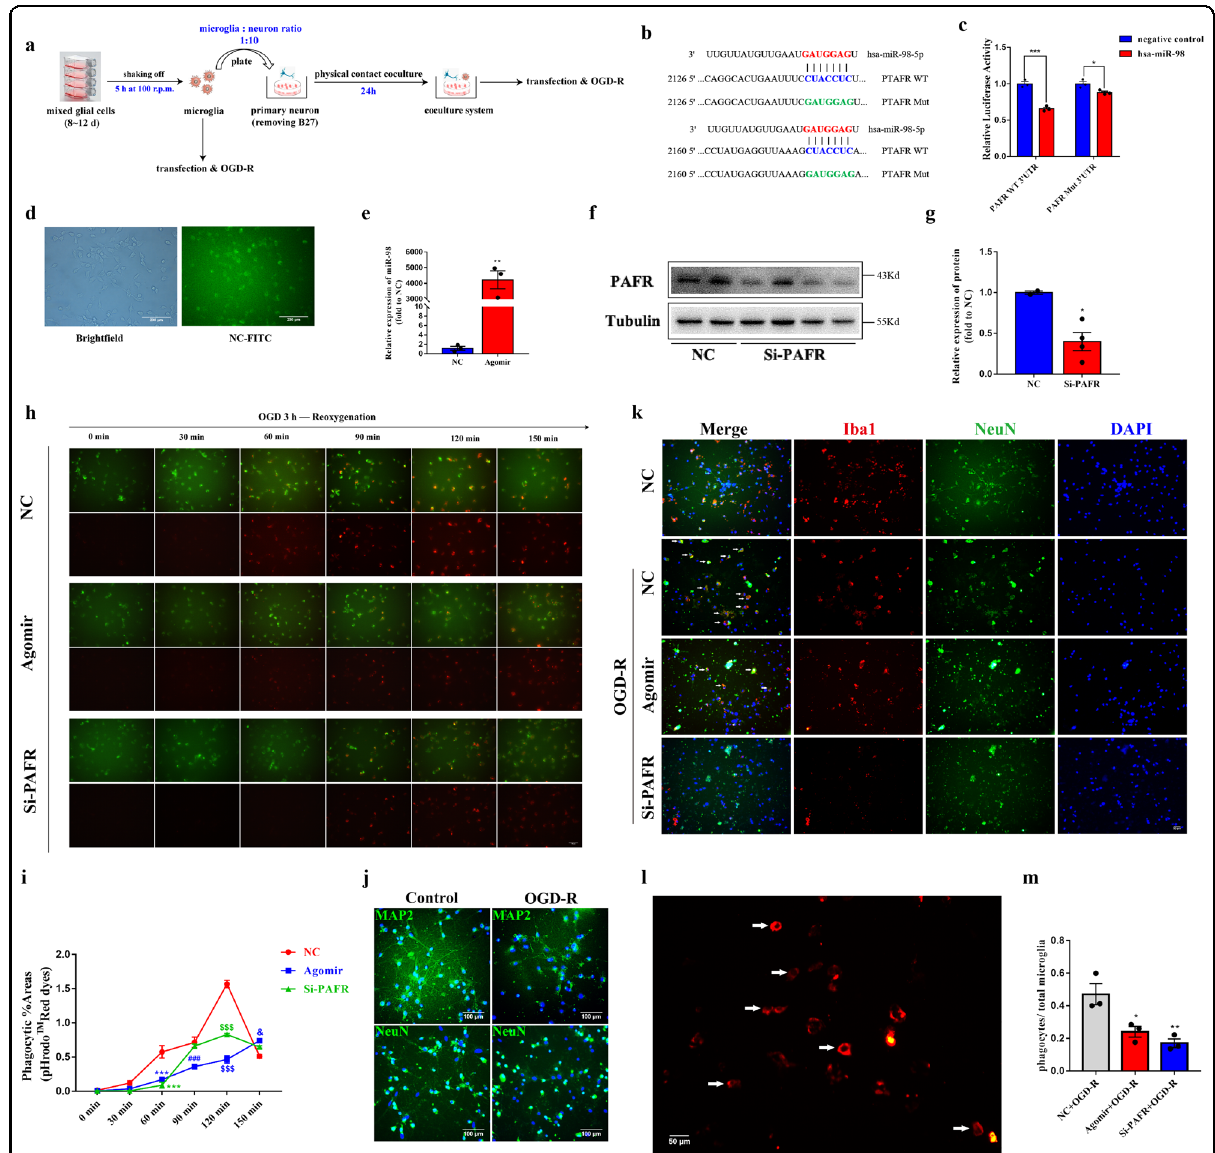
Fig. 4 MiR-98 could inhibit the microglial phagocytosis of neuron after OGD/R in vitro. a The procedure of primary microglia transfection, OGD/R and physical contact co-cultured with neuron. b The target sequence of hsa-miR-98 and WT & Mut PAFR 3 ′ -UTR. c The effect of hsa-miR-98 on PAFR expression via dual-luciferase report system. d The transfection ef fi ciency of negative control (NC-FITC). e The transfection ef fi ciency of miR-98 agomir. f – g The transfection ef fi ciency of PAFR-siRNA. h – i The CellTracker TM Green-labeled microglial phagocytosis of pHrodo TM Red Dextran dye after treated with OGD 3 h and reoxygenation during the time course from 30 min to 150 min and quanti fi cation of the phagocytic %area. (Scale Bar = 100 μ m). j Representative immunological staining of NeuN and MAP2 after primary neuron treated with 2 h OGD and reoxygenation for 24 h. (Scale Bar = 100 μ m). k The representative images of the effects of overexpressing miR-98 and downregulating PAFR on the microglial phagocytosis of neurons after treated with OGD 2 h and reoxygenation for 24 h. The white arrows mean representative microglial phagocytosis of neurons. (Scale Bar = 50 μ m). l – m The representative phagocytes of microglia and quanti fi cation of the percentage of phagocytes/total microglia numbers. (Scale Bar = 50 μ m) Data are shown as means±S.E.M., * P , & P < 0.05; ** P < 0.01; *** P , ### P , $$$ P < 0.001 vs corresponding control. ( n = 3 independent